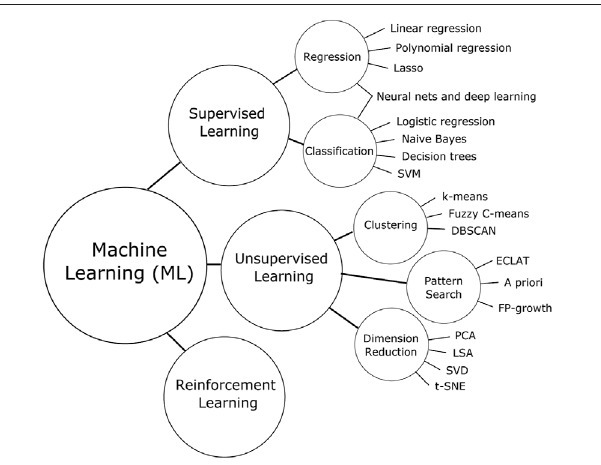
FIGURE 2 | Traditional vs. AI algorithms.